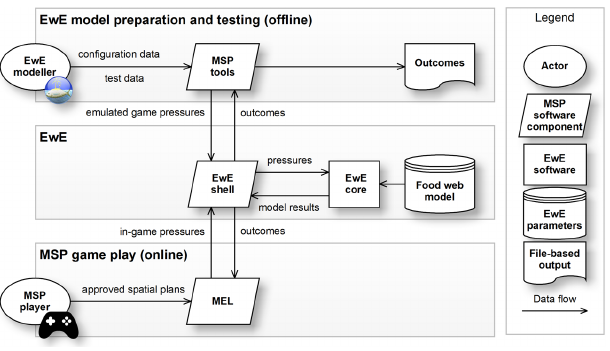
Fig. 2. An overview of software components needed to connect the Ecopath with Ecosim (EwE) computational core to the marine spatial planning (MSP) challenge. EwE shell is the central software library that encapsulates the EwE modeling logic to receive MSP player-derived pressure layers and to deliver outcome layers back to the MSP software system.